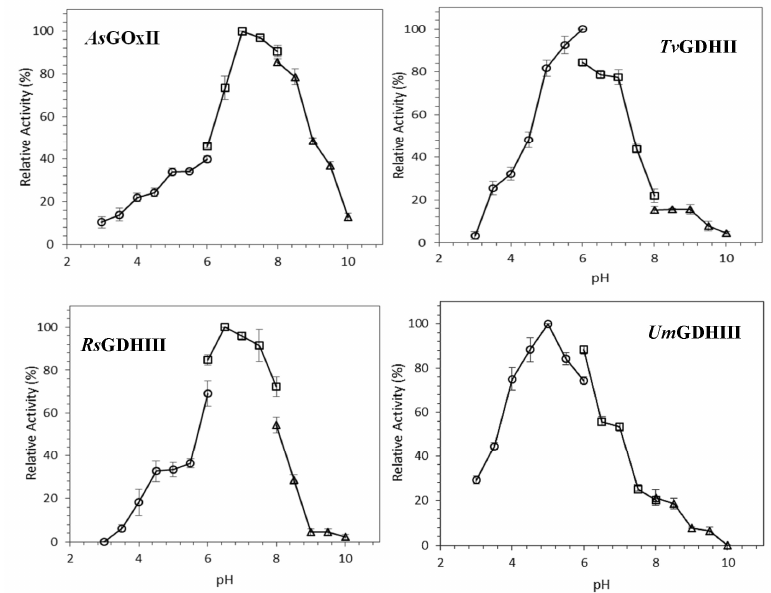
Figure 2. Influence of the pH value on the activity of AA3_2 glucose oxidoreductases. Relative activities measured at various pH values for the substrate couple D-glucose/1,4-BQ. The buffers were 50 mM potassium citrate (о), potassium phosphate (Δ), and Tris-HCl (Δ). Values represent the mean ± SD of triplicate independent measurements.